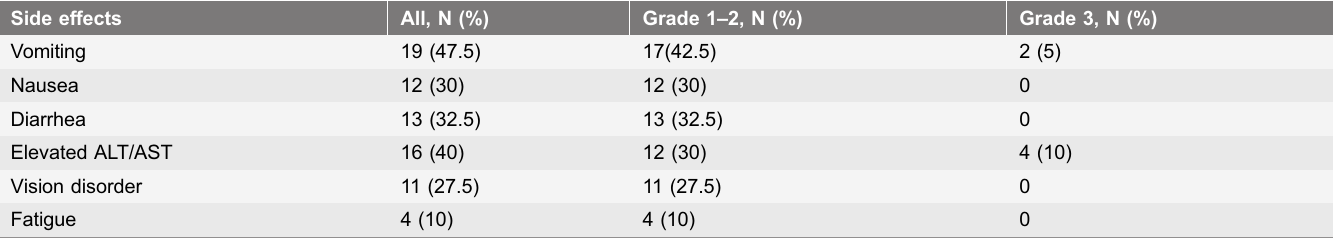
Table 3. Common side effects of 40 Chinese patients treated with